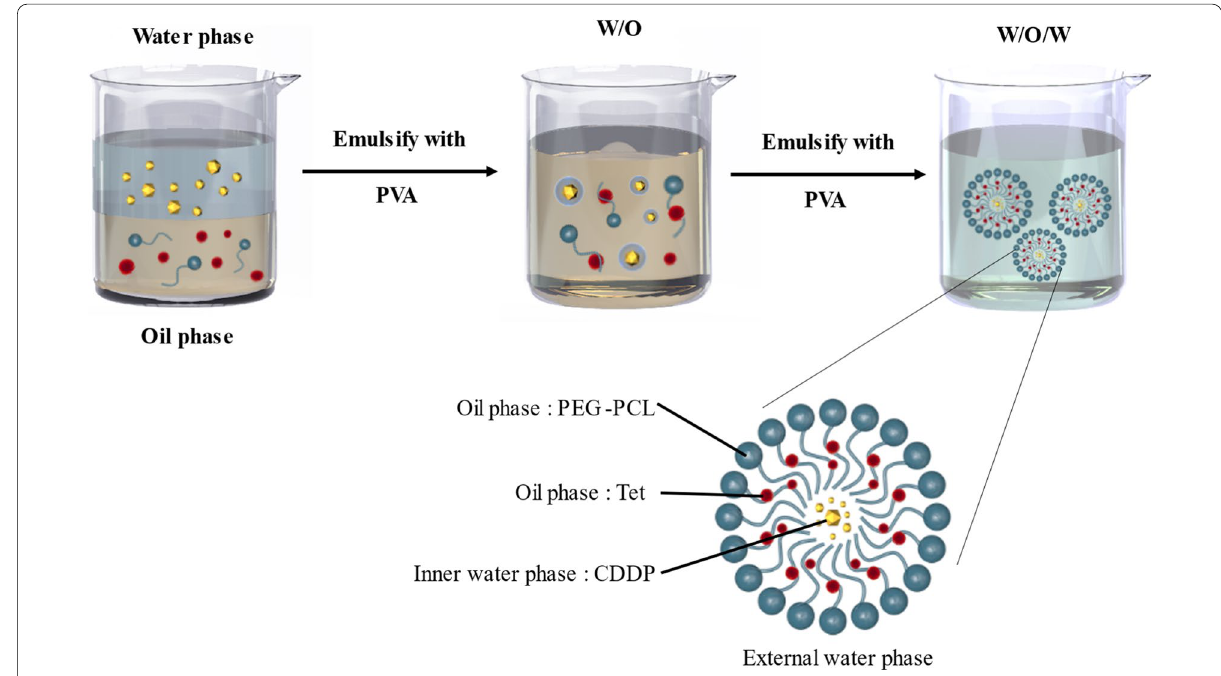
Fig. 1 The scheme of CDDP-Tet NPs